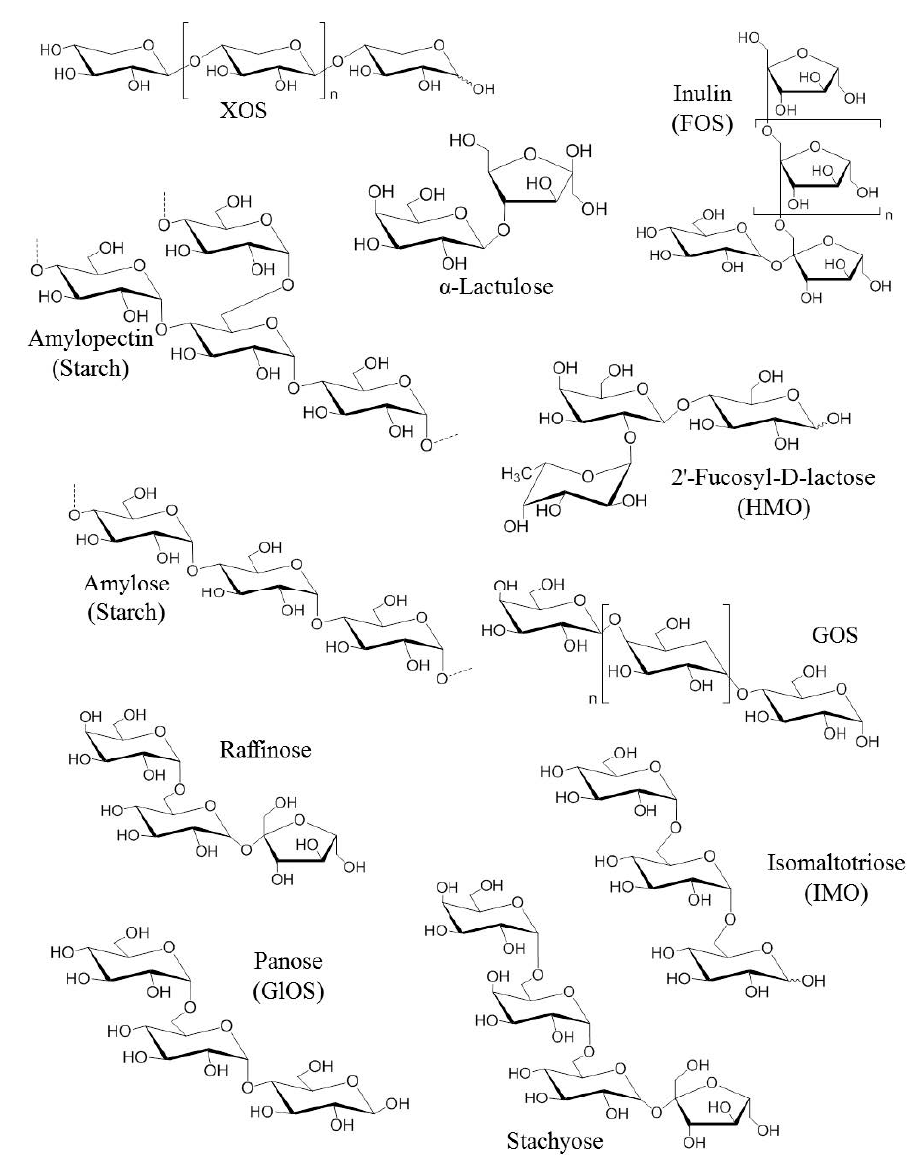
Figure 1. Chemical structures of the first generation of prebiotics. FOS: Fructo-oligosaccharides, GlOS: Gluco-oligosaccharides, GOS: Galacto-oligosaccharides, HMO: Human milk oligosaccharides, IMO: Isomalto-oligosaccharids [22].